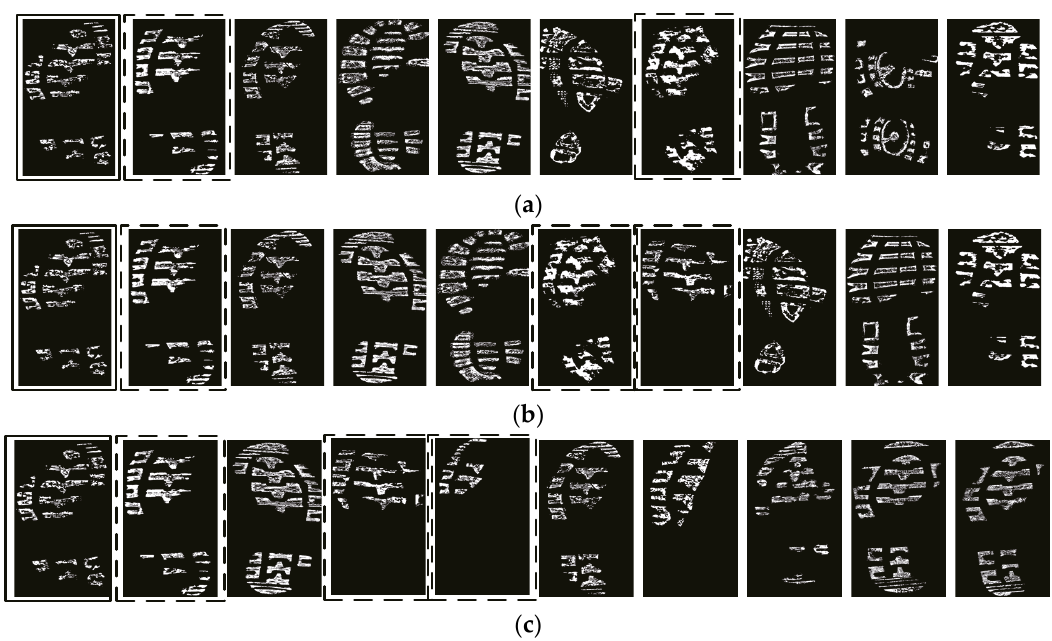
Figure 5. Results of our method and the compared methods. The top 10 in the ranking list of our method and the compared methods are presented. Shoeprints encircled by the solid boxes are the query shoeprints, and those encircled by dotted boxes are their counterparts. ( a ) Wang et al. 2014 [28]. ( b ) The proposed hybrid feature. ( c ) The proposed neighborhood-based similarity estimation (NSE) method.